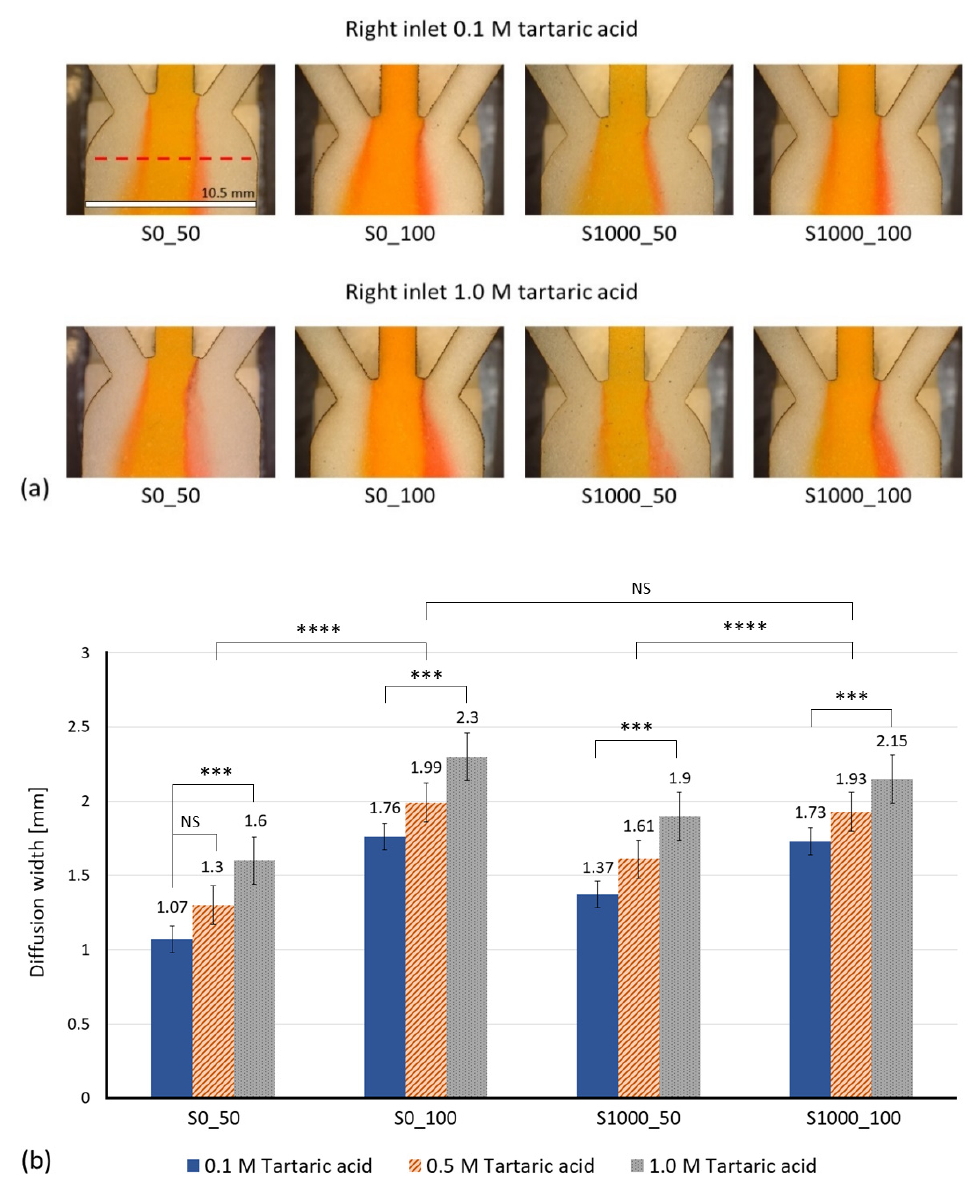
Figure 12. ( a ) Visual comparison of diffusion development in different paper substrates at 30 s after the “Time zero”. The measurement line is shown as the dashed line. Scale Bar is 10.5 mm. ( b ) Measured diffusion width based on the changes in the intensity of the green channel for different concentrations of tartaric acid. The asterisk (*) represents the p -value of the statistical test. (*** p < 0.001, **** p < 0.0001, NS: non-significance).